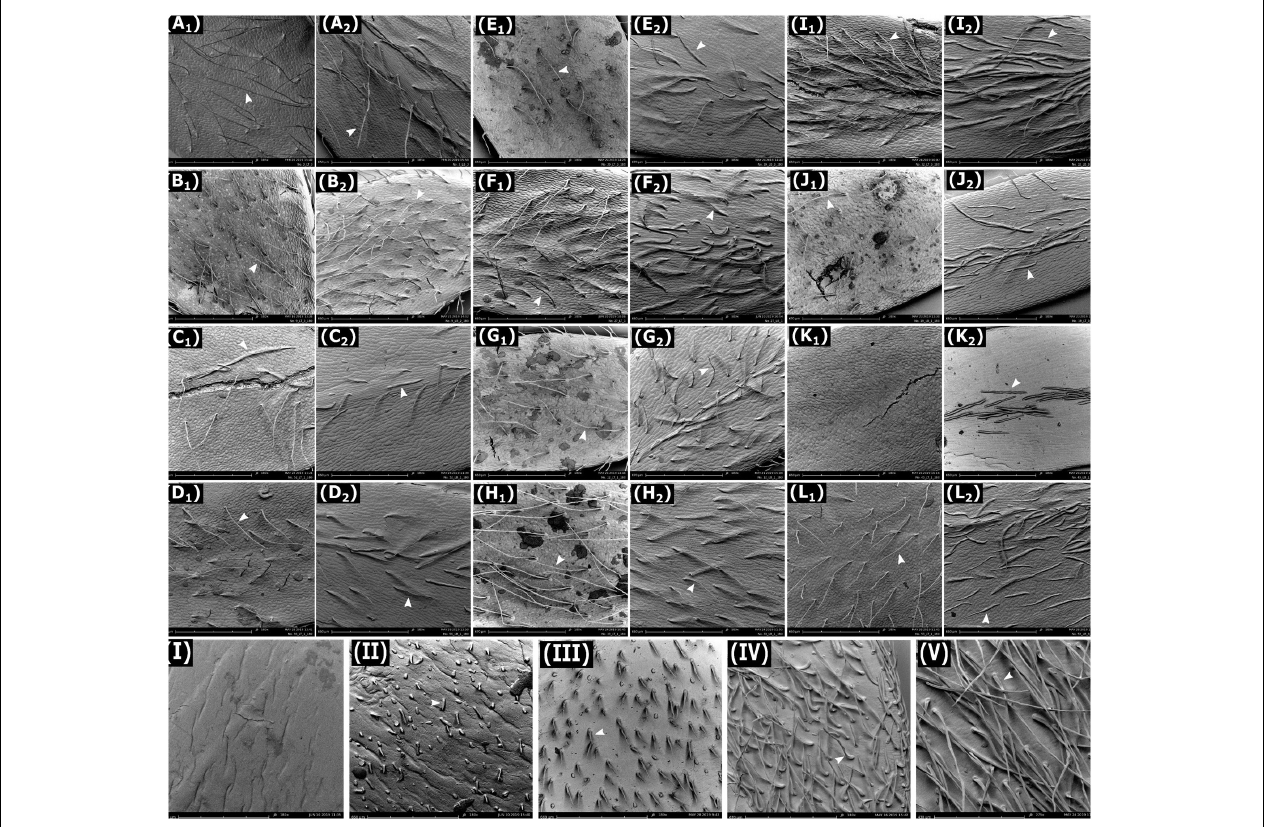
FIGURE 2 | Scanning electron microscopy images of adaxial (indicated as subscript 1) and abaxial (indicated as subscript 2) surfaces of leaflets of lentil genotypes. (A) L. cul. Indianhead and (B) L. cul. CDC Redberry at 185X magnification and the following at 180X magnification: (C) L. cul. CDC Greenstar, (D) L. ori. IG 72643, (E) L. ori. PI 572376, (F) L. tom. IG 72613, (G) L. tom. IG 72614, (H) L. tom. IG 72805, (I) L. ode. IG 72623, (J) L. lam. IG 110813, (K) L. erv. L-01-827A, and (L) L. nig. IG 116024. Images (I–V) are surfaces of lentil pods at 180X magnification for (I) L. cul. Indianhead, (II) L. cul. CDC Redberry, (III) L. erv. L-01-827A,